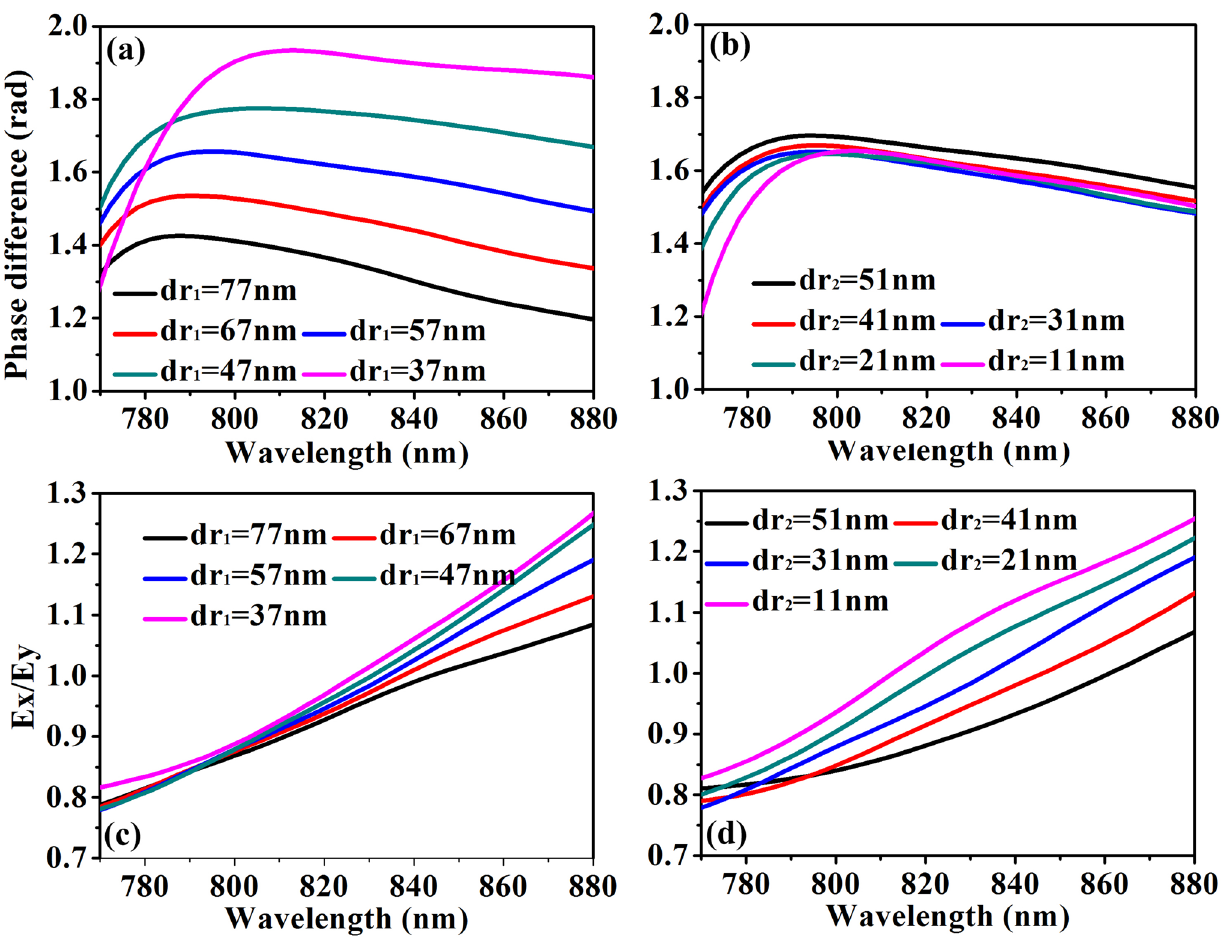
Figure 4. The amplitude ratio and the phase difference. ( a ) The phase difference and ( b ) the amplitude ratio of transmitted light under xy -polarized incidence. ( a , c ) dr 1 decreases from 77 to 37 nm and dr 2 = 31 nm. ( b , d ) dr 2 decreases from 51 to 11 nm and dr 1 = 57 nm. The other parameters are h = 8 nm and p = 330